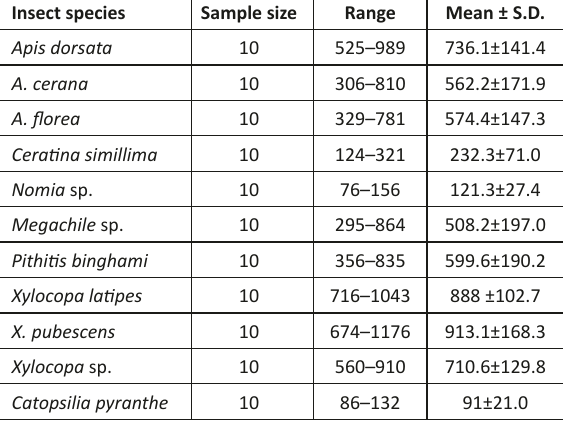
Table 3. Pollen carrying capacity of insect foragers on Derris